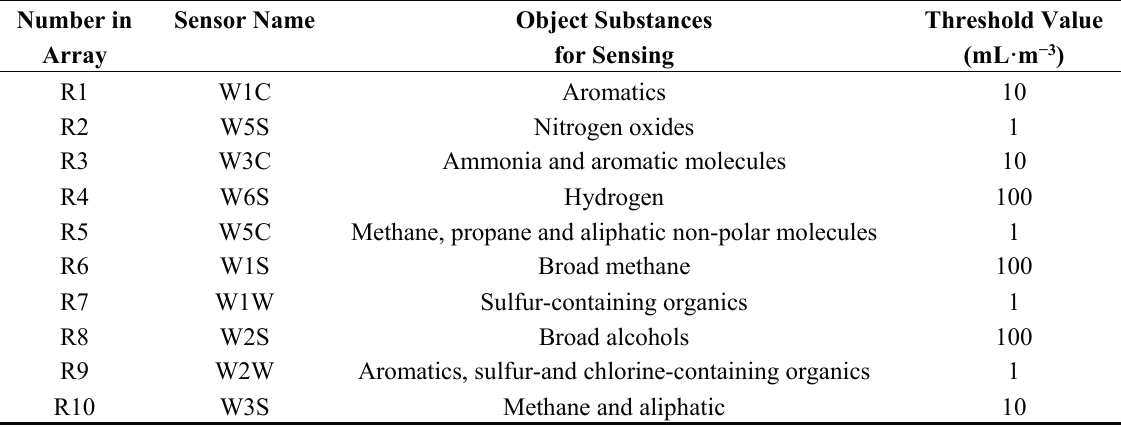
Table 6. Response features of the sensor